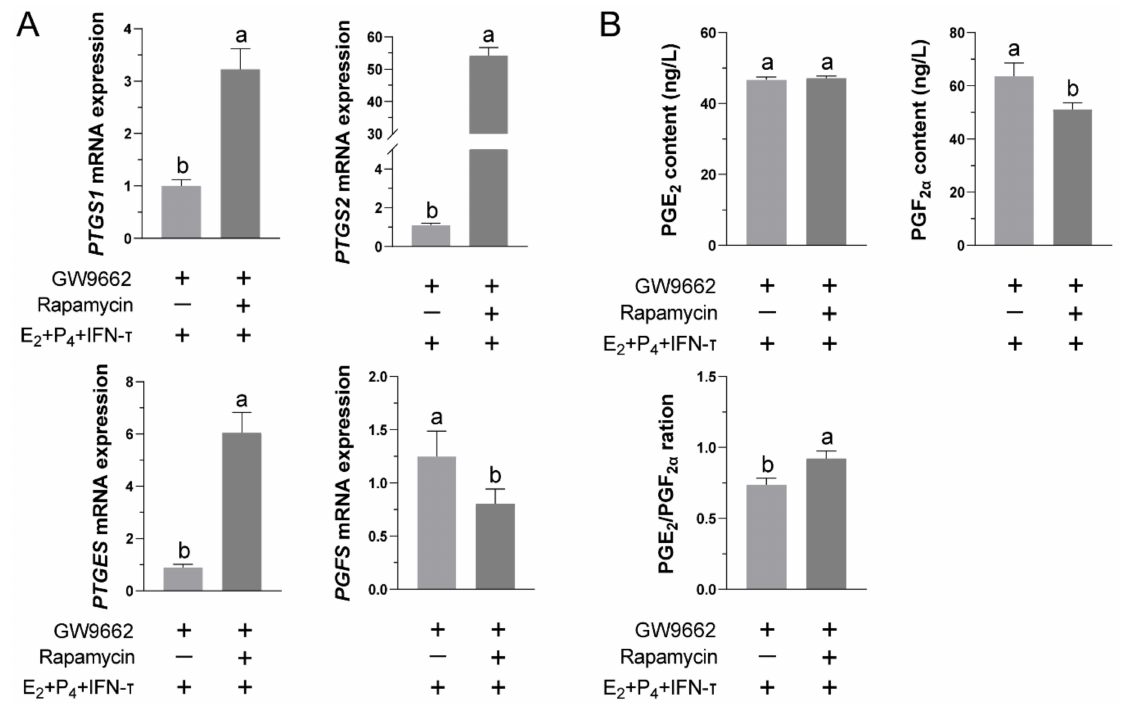
Figure 6. Influence of crosstalk between PPAR γ and mTOR on the secretion of PGs in STCs under hormone treatment: Under hormone treatment, the mTOR pathway was first blocked, and then GW9662 was added for preconditioning. The culture medium supernatants were collected, and PGs were measured by ELISA, while RT-qPCR of the total RNA of the STCs was performed to determine the mRNA levels. ( A ) The relative mRNA level of the rate-limiting enzyme in PGs synthesis was quantified by RT-qPCR, with the β -actin gene used as the control in all samples. ( B ) Secretion of PGE 2 and PGF 2 α was detected by ELISA, and the ratio of PGE 2 /PGF 2 α was calculated. Data are expressed as the mean ± SD of three independent experiments. Different letters above the bars indicate significant differences ( p <